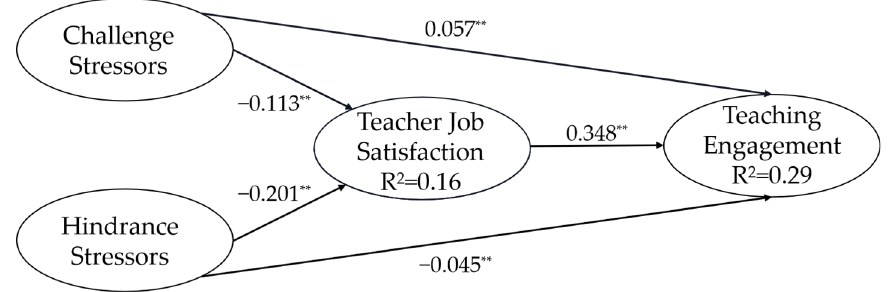
Figure 2. Structural equation model of challenge—hindrance stressors, teacher job satisfaction, and teaching engagement. Note: ** p < 0.01, N = 7743.